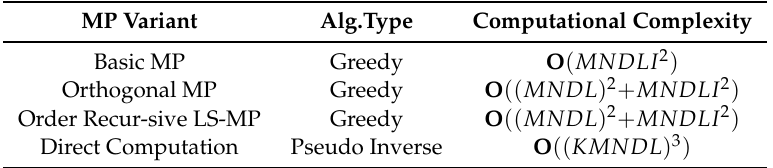
Table 2. Complexity of matching pursuit (MP) algorithm variants. K = window length, D = number of delays, L = the Doppler shifts, M = number of transmitters, N = number of receivers and I = algorithm